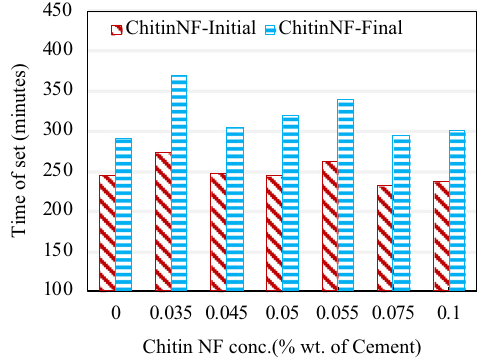
Figure 23: E ff ect of concentration of chitin nano fi bers on the setting time of cement